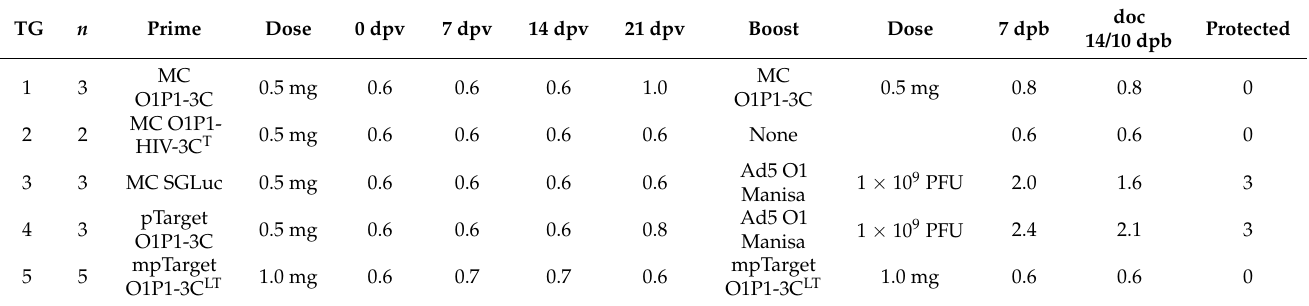
Table 1. Average virus neutralization antibody titers against FMDV O1 Manisa in cattle. Boost